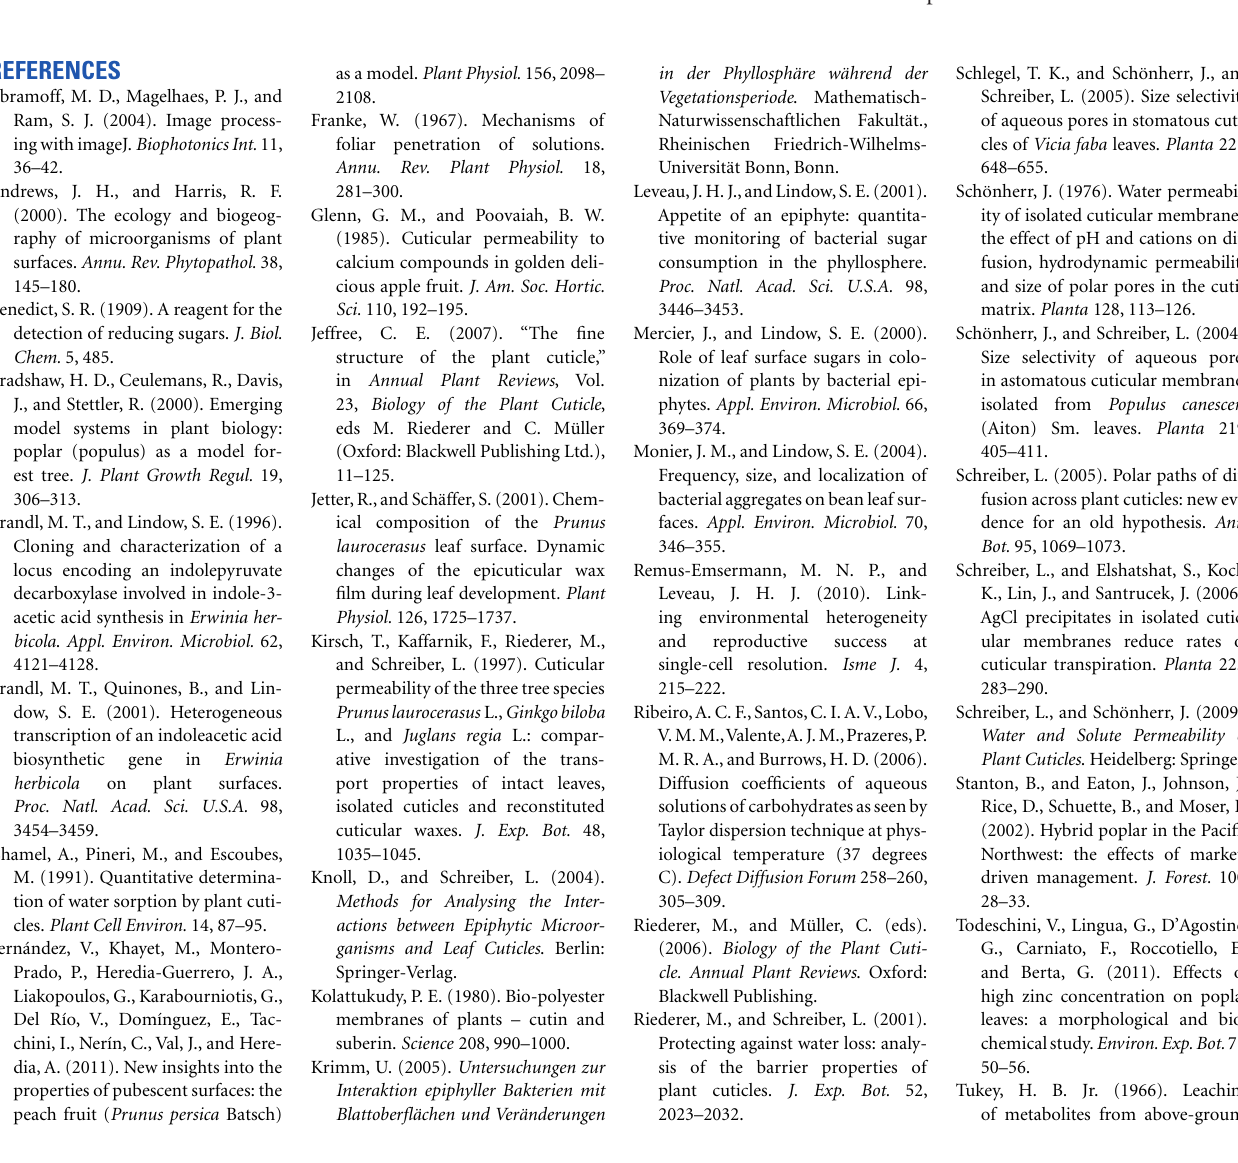
FIGURE 4 | Probability plot of the log-transformed size of fructose-permeable sites (in μ m 2 ) found on enzymatically isolated Populus x canescens CMs. Data points were derived and pooled from three individual